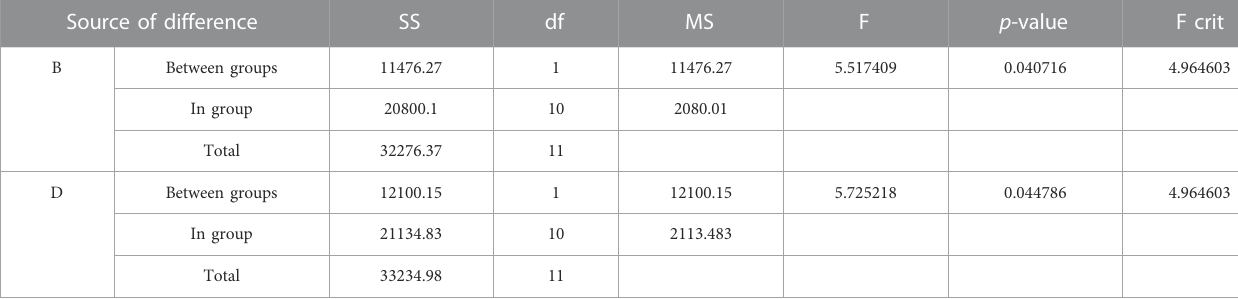
TABLE 12 Variance analysis of ultrasonic power on point B and point D.